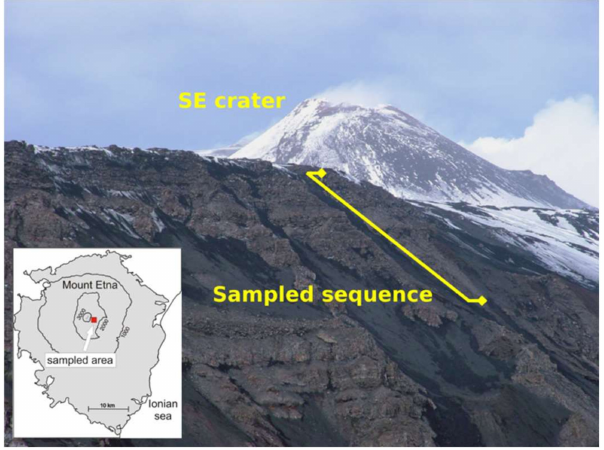
Figure 1. View of the sampled volcanic sequence outcropping in the uppermost part of the western wall of the Valle del Bove at Mount Etna.